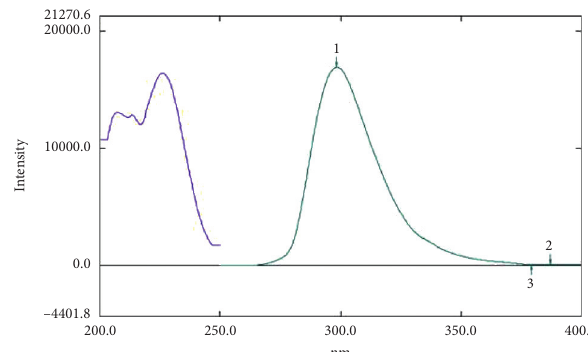
Figure 2: Fluorescence intensity for neat sample of EFN (750 ng/ mL) in methanol at emission (299.4 nm) after excitation at 226.5nm.